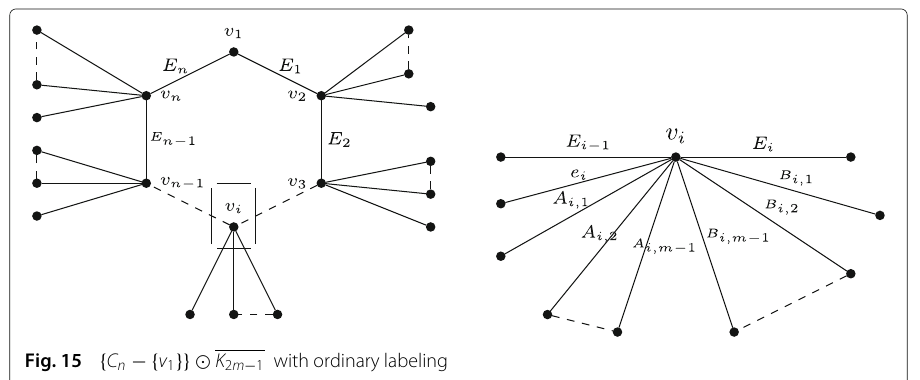
Fig. 15 { C n − { v 1 }} (cid:4) K 2 m − 1 with ordinary labeling